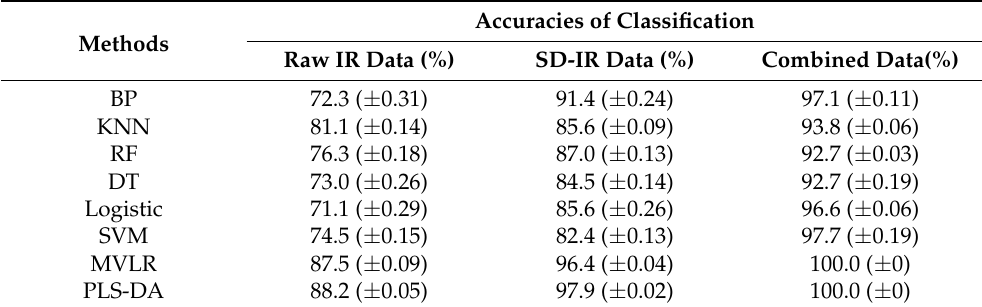
Table 3. Comparison of classification accuracies of methods based on different feature